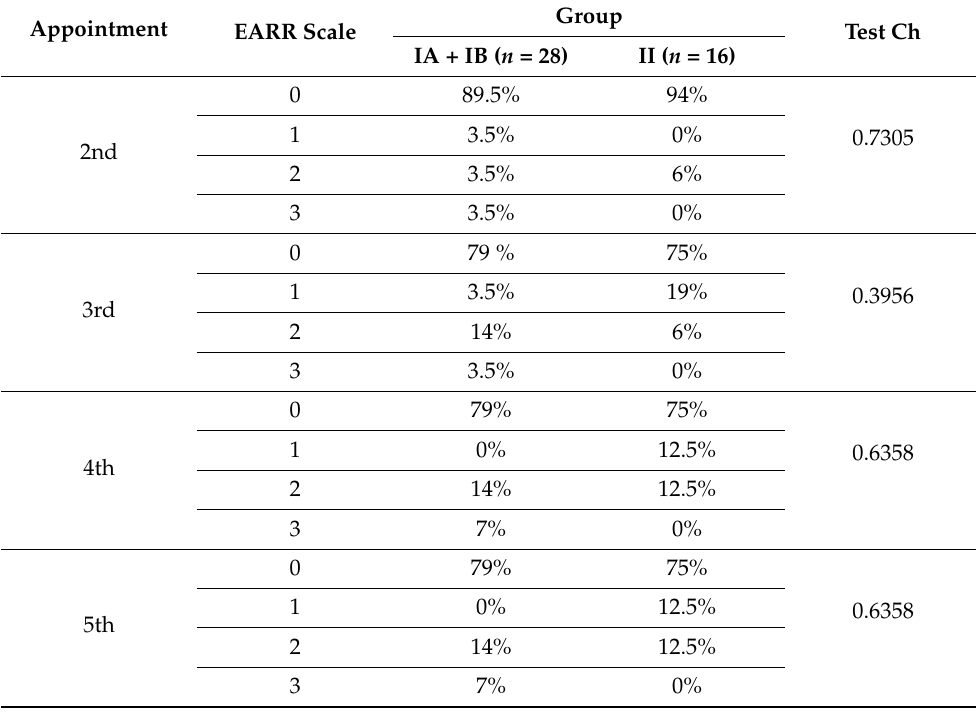
Table 9. The distribution of external apical root resorption severity evaluated during each orthodontic appointment ( n —number of teeth).